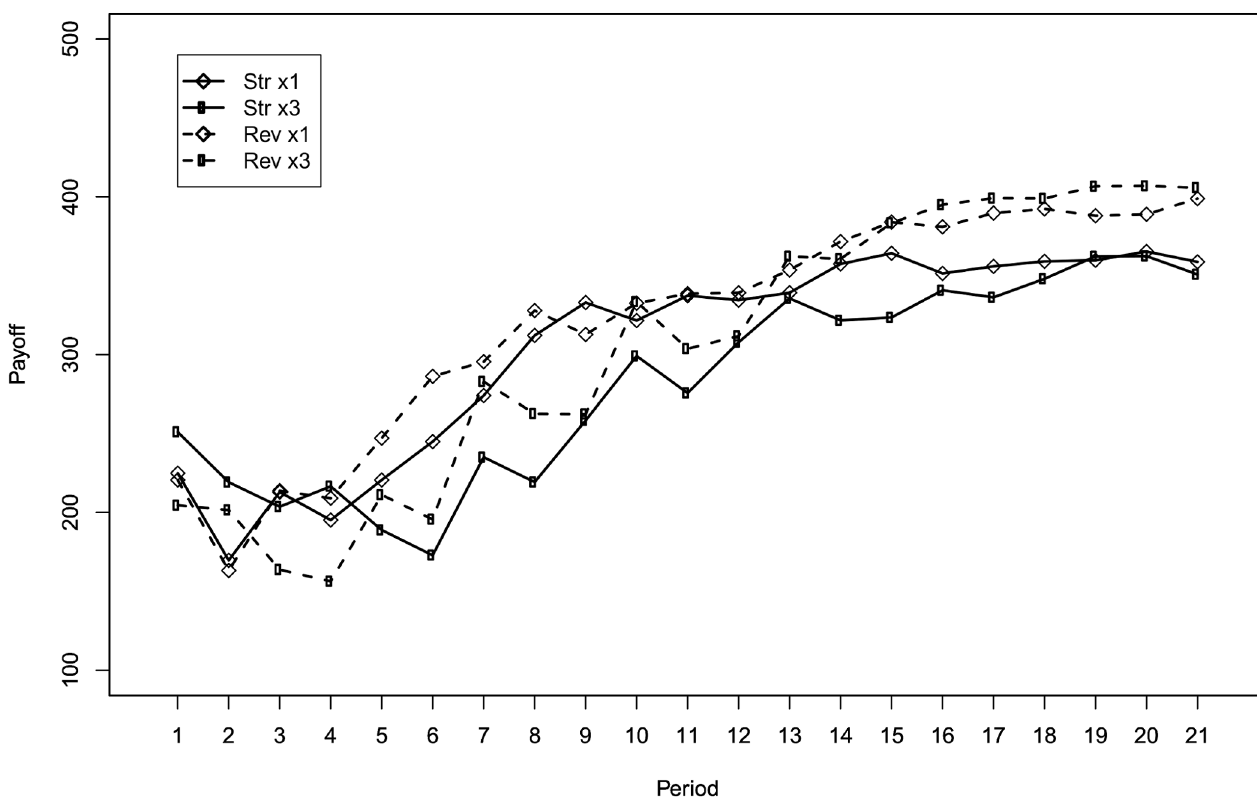
Fig 3. Averagepayoff by round and